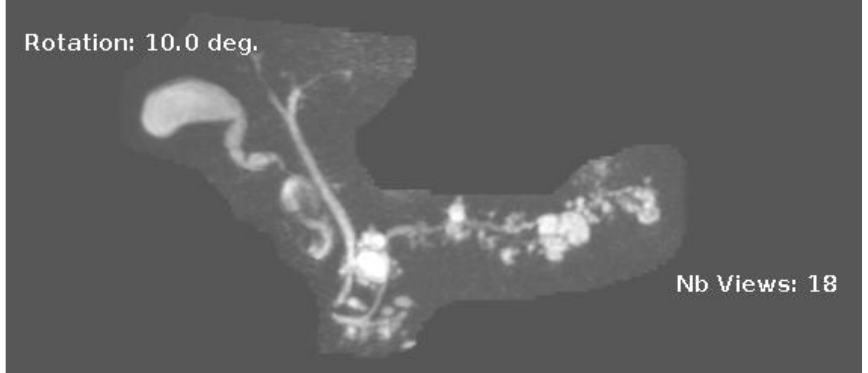
Figure 3. MRI image of side branch IPMN.